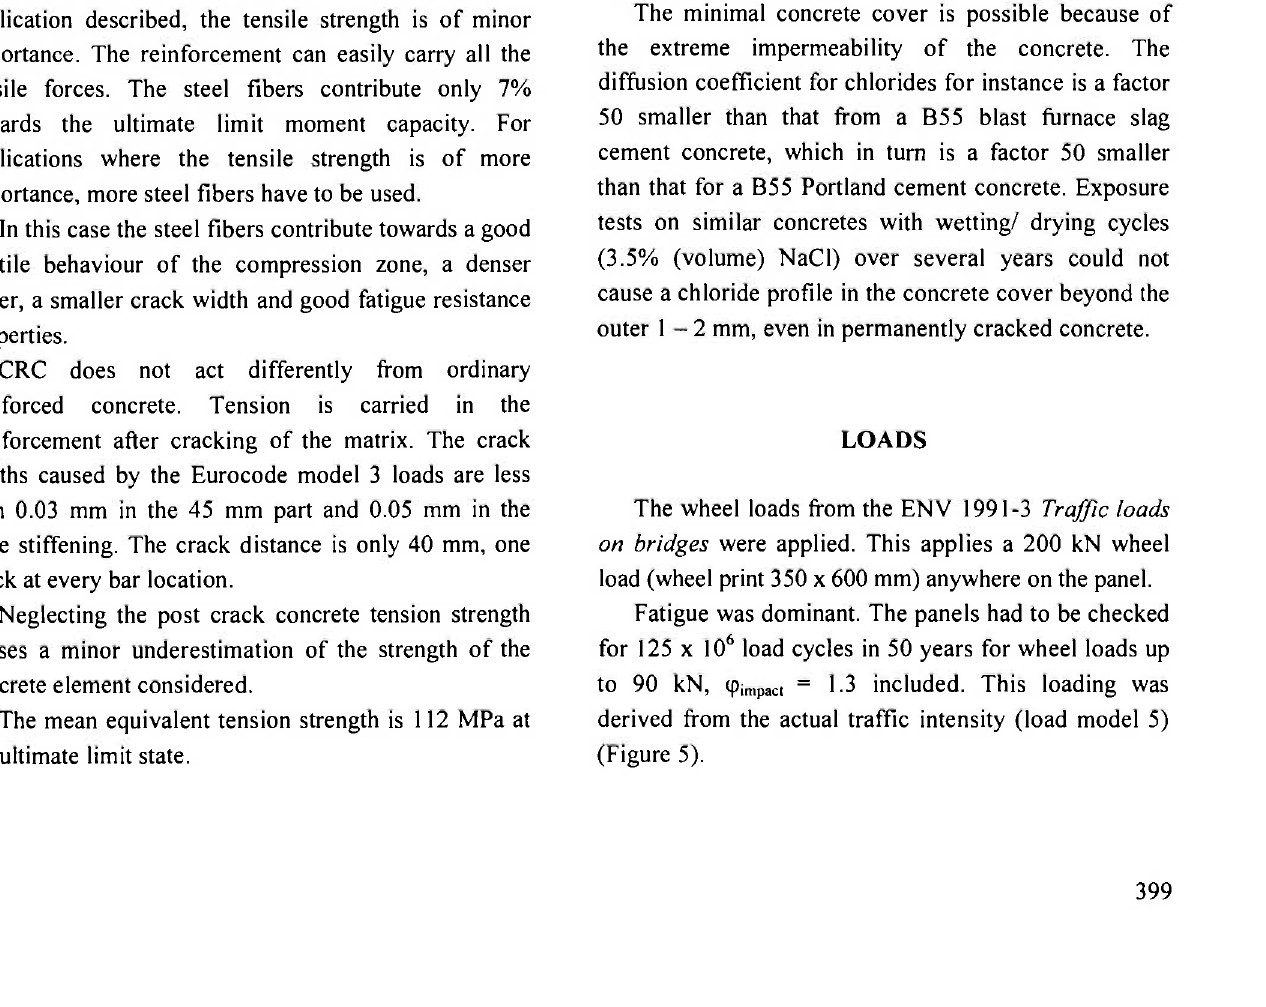
Fig. 3: Stress/ strain diagram for concrete (design